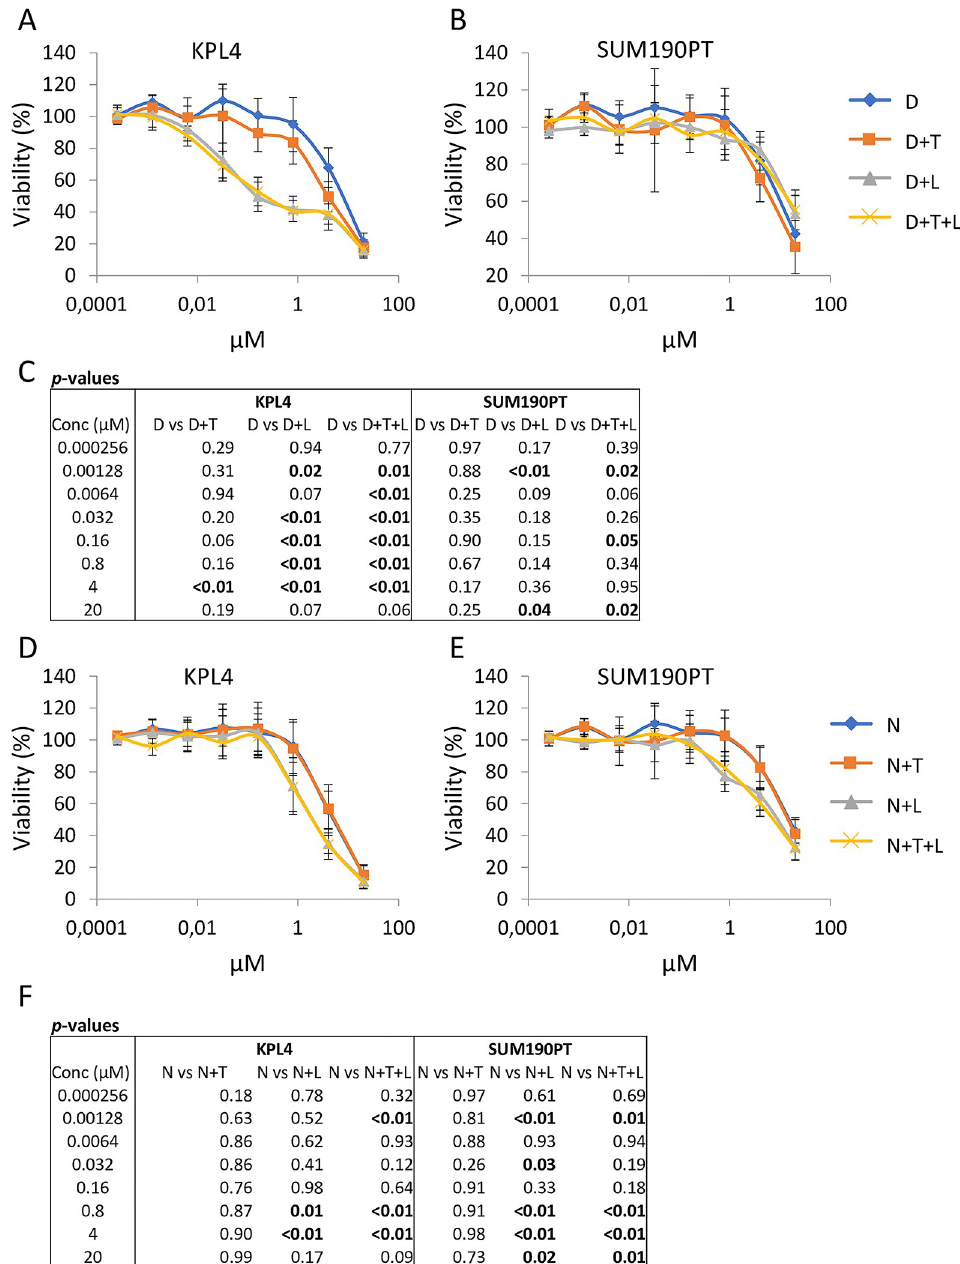
Fig 2. Dose response curves after single drug and combinatorial treatment in HER2+ breast cancer lines. Cell viability measurements after treatment with increasing doses of dasatinib alone and in combination with trastuzumab (10 μ g/mL) and lapatinib (0.1 μ M) in A) KPL4 cells, and B) SUM190PT cells. Table of p -values is presented in panel C). Treatment with increasing doses of navitoclax alone and in combination with trastuzumab (10 μ g/mL) and lapatinib (0.1 μ M) in D) KPL4 cells, and E) SUM190PT cell. Table of p -values is presented in panel F). Student’s t-test p -values are calculated between treatment groups at the indicated concentrations. P- values < 0.05 are considered significant and are highlighted in bold font. Error bars represent the standard deviation for 4 technical replicates repeated in two biological experiments. D, Dasatinib; L, Lapatinib; T, Trastuzumab; N, Navitoclax.